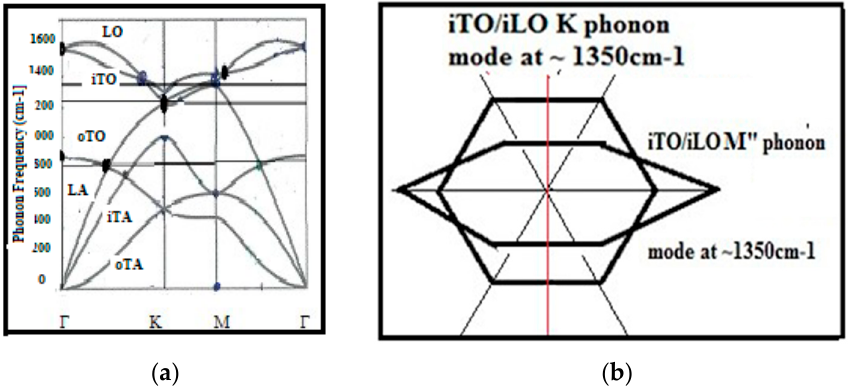
Figure 13. Phonon dispersion curves in graphene by Lazzari et al. [227] with permission of Physical Review B. ( a ) At 1350 cm − 1 (the frequency of so-called Raman D “disorder” peak) two coupled phonon vibration modes corresponding to K and M modes and only the K mode is Raman active. ( b ) Representation of K and M coupled vibration mode for a hexagonal sp2 ring with perpendicular wave vectors. K mode corresponds to the vibration of A edge meanwhile the M mode is the vibration mode of the ZZ edge. iTO in-plane transverse optical mode, oTO out of plane transverse optical mode, LO Longitudinal optical mode, LA longitudinal acoustical mode, iTA in-plane acoustical mode, oTO out of plane acoustical mode Table 1. Raman nomenclature for carbon material characterizing.